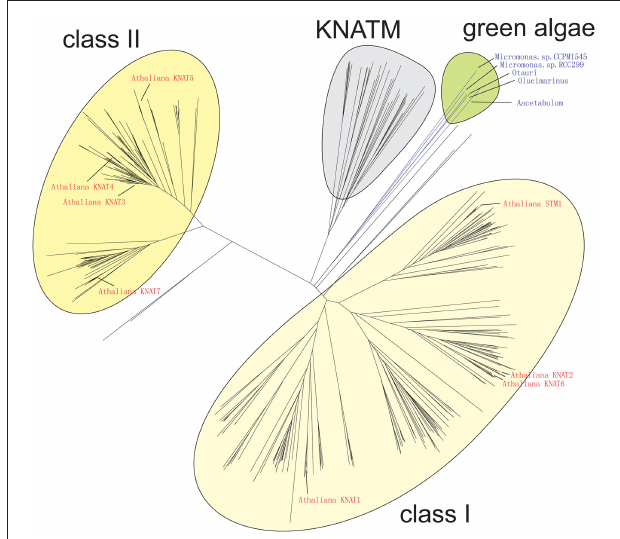
FIGURE 2 | Grouping of KNOX homologs. A collection of 394 KNOX proteins were grouped using neighbor-joining. Sequences of A. thaliana and green algae are